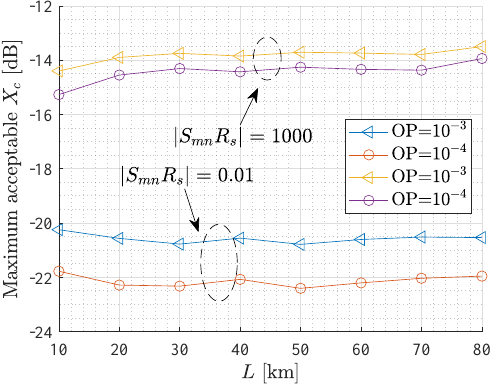
Figure 3. Maximum acceptable ICXT level required to achieve the OP = 10 − 3 and OP = 10 − 4 as a function of the MCF length, for | S mn · R s | = 0.01 and | S mn · R s | = 1000, for r =